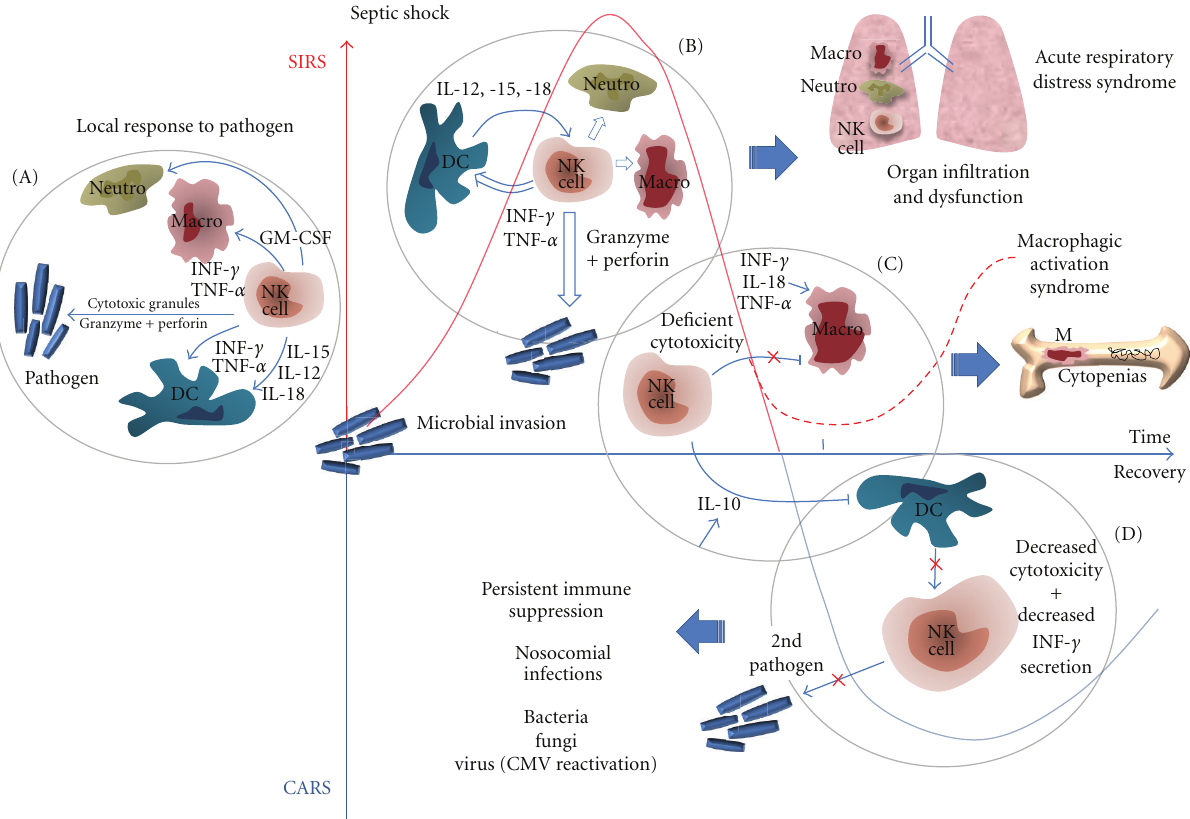
Figure 2: (A) NK cells initiate a local inflammatory response to pathogens. (B) During SIRS, NK cells amplify the inflammatory response to the spread of the pathogen, which can lead to organ dysfunction. (C) Deficient NK cell cytotoxicity may favor macrophage activation syndrome. (D) During CARS, NK cell global dysfunction may favor nosocomial infections. Note: SIRS and CARS have been separated in time to ease understanding of the figure, but the di ff erent stages (B–D) can occur simultaneously. Also, most data shown here are from mouse models and should be further confirmed in septic